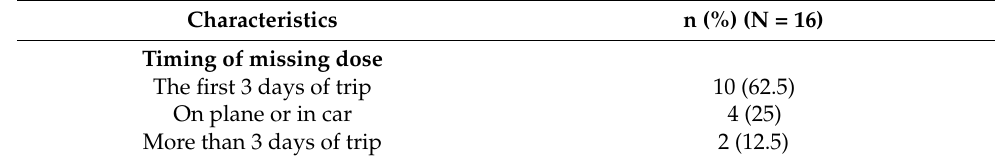
Table 3. Characteristics of moderate-to-poor adherence among Thai travellers living with